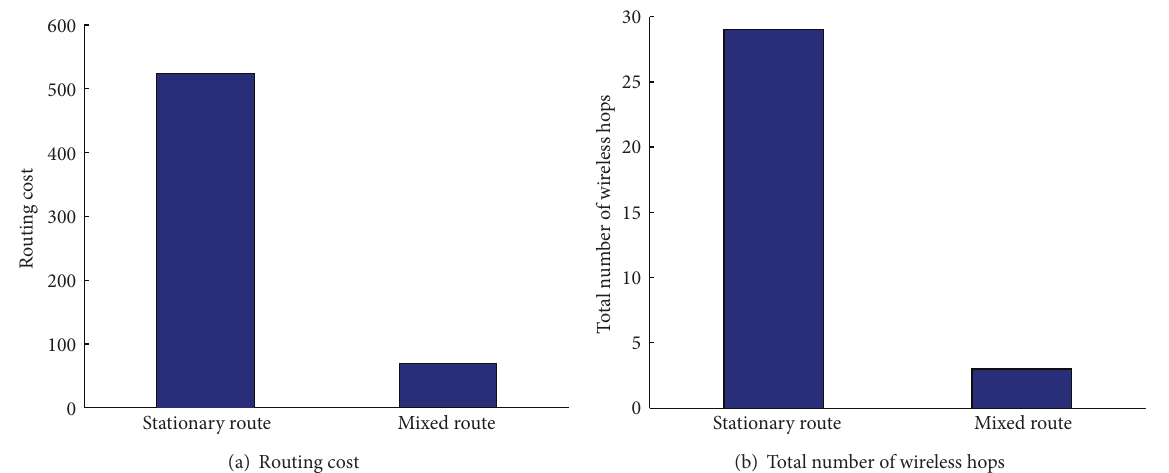
Figure 9: Network performance comparison for the shortest stationary routing versus proposed mixed routing (with the packet deadline of 250 s and the interarrival time of